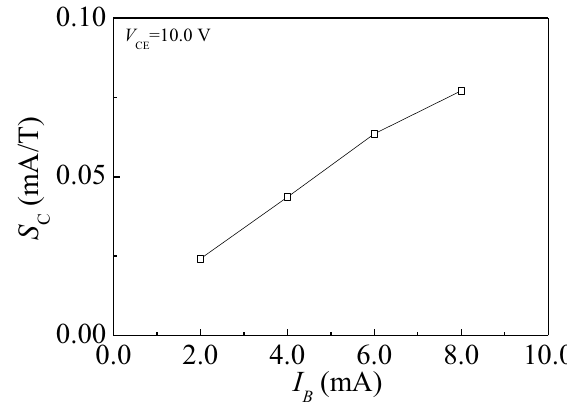
Figure 11. The relationship curve between S C and I B